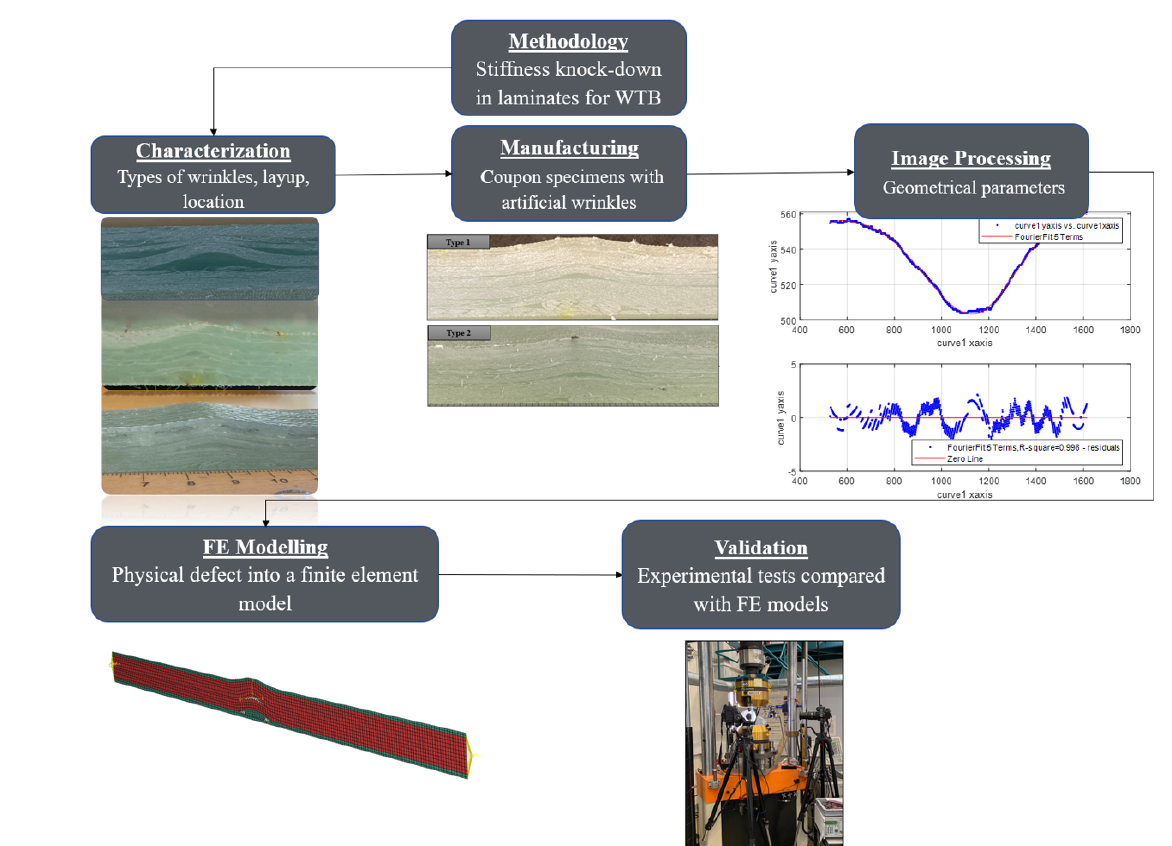
Figure 2. Schematic of the steps used to carry on the methodology of analysis to evaluate the stiffness knock-down of laminates for WTB.